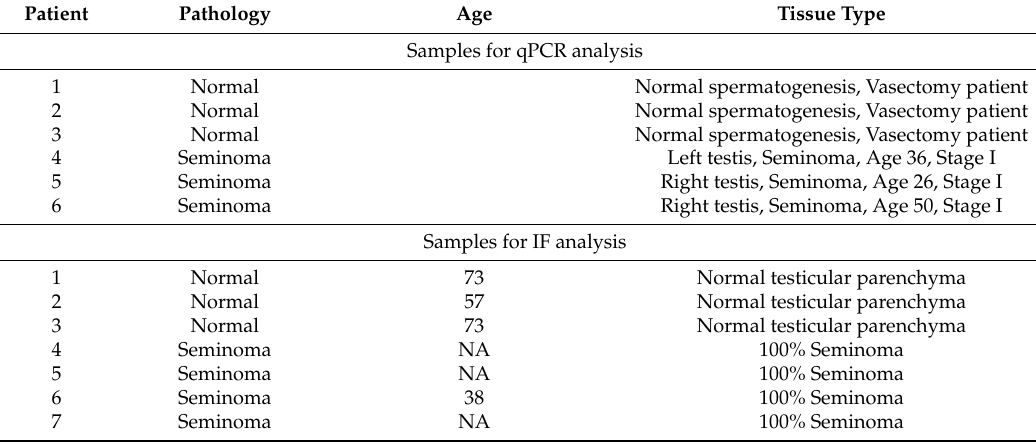
Table 1. Human normal and tumoral testicular tissue